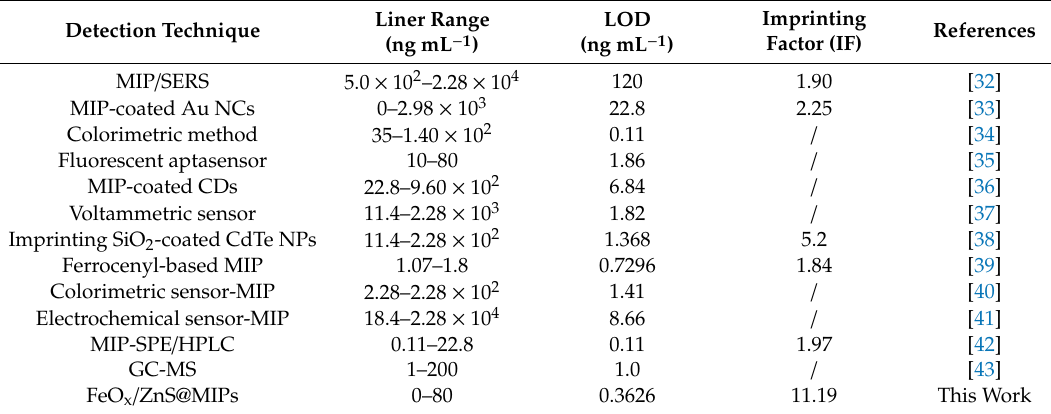
Figure 6. Fluorescence emission spectra of ( a ) FeO x / ZnS@MIPs and ( b ) FeO x / ZnS@NIPs with increasing concentrations of BPA. Inset graphs: the linear calibration of the fluorescence intensity change ( F 0 / F ) versus BPA concentration. Experimental conditions: BPA (0, 5, 10, 20, 30, 40, 50, 60, 70, 80 ng mL − 1 ), citrate bu ff er solution (0.02 mol L − 1 , pH = 6.4), room temperature.